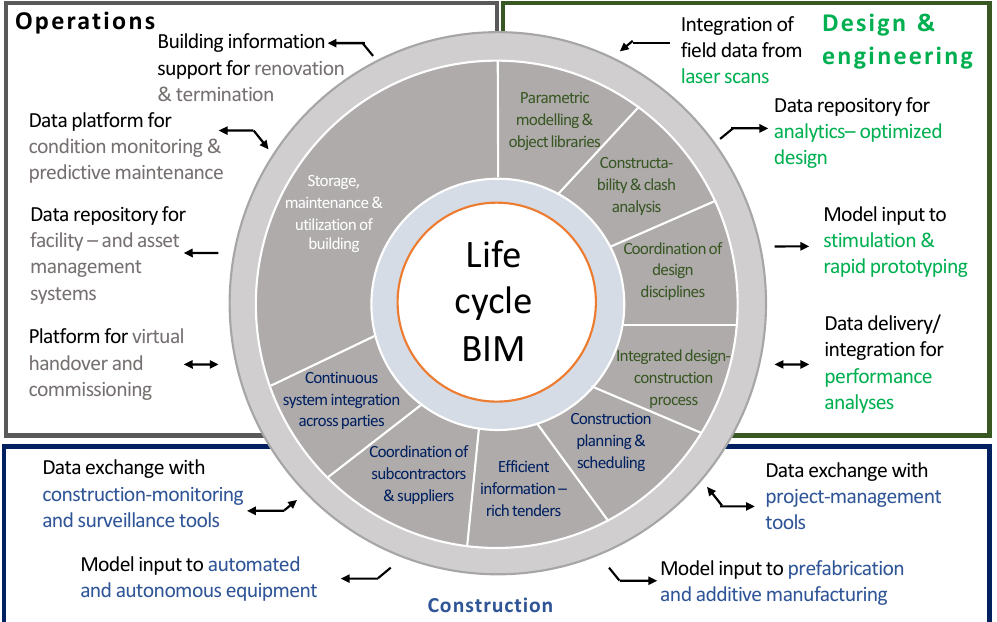
Figure 2. Application of BIM along the construction value chain ([43], adapted).